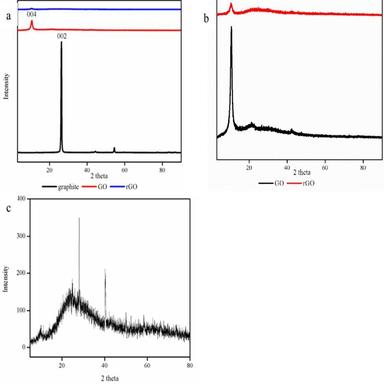
XRD patterns of (a) graphite, GO and rGO; (b) enlarged view of GO and rGO; (c) PEDOT/rGO.